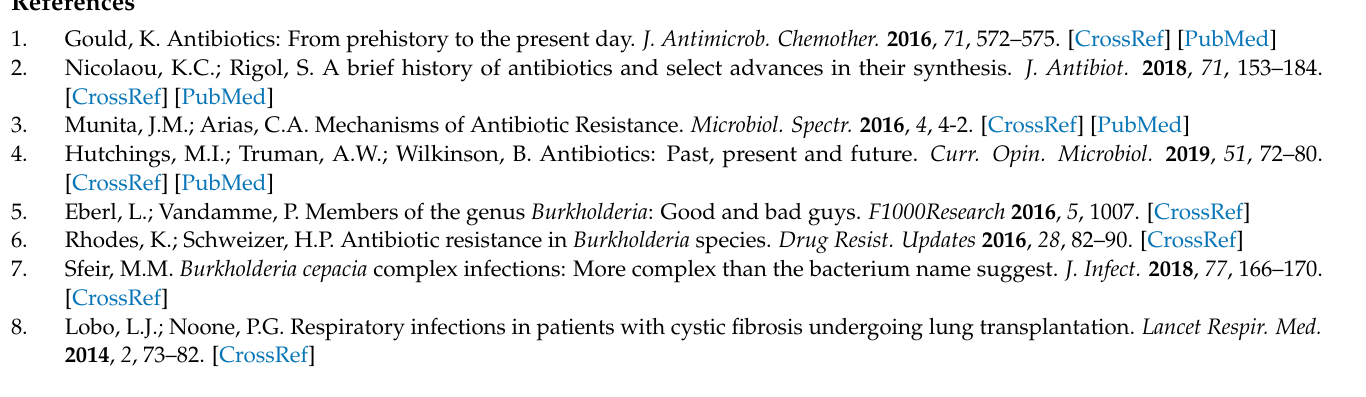
Figure S3. 31 P NMR spectrum of compound WB-19-HL4170 (MS-40S) in CDCl 3 . Figure S4. 1 H NMR spectrum of compound WB-19-HL4171 in CDCl 3 . Figure S5. 13 C NMR spectrum of compound WB-19-HL4171 in CDCl 3 . Figure S6. 31 P NMR spectrum of compound WB-19-HL4171 in CDCl 3 . Figure S7. 1 H NMR spectrum of compound WB-19-HL4172 in CDCl 3 . Figure S8. 13 C NMR spectrum of compound WB-19-HL4172 in CDCl 3 . Figure S9. 31 P NMR spectrum of compound WB-19-HL4172 in CDCl 3 . Figure S10. 1 H NMR spectrum of compound WB-19-HL4181 in CDCl 3 . Figure S11. 13 C NMR spectrum of compound WB-19-HL4181 in CDCl 3 . Figure S12. 31 P NMR spectrum of compound WB-19-HL4181 in CDCl 3 . Figure S13. 1 H NMR spectrum of compound WB-19-HL4121a in CD 2 Cl 2 . Figure S14. 31 P NMR spectrum of compound WB-19-HL4121a in CD 2 Cl 2